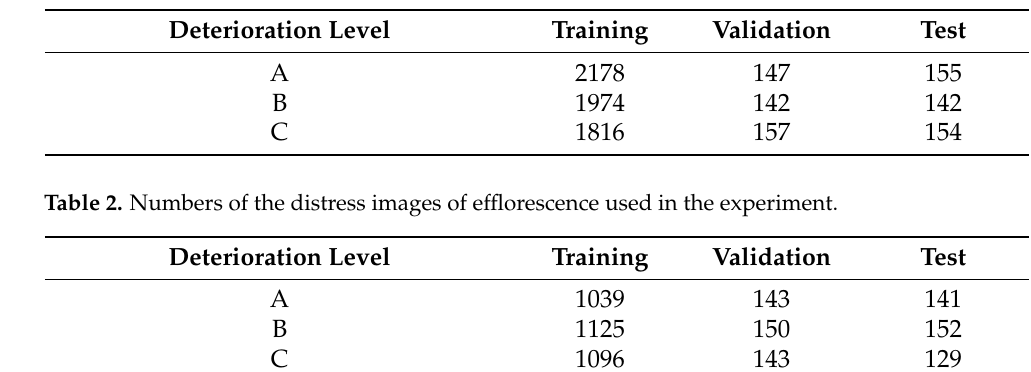
Table 1. Numbers of the distress images of corrosion used in the experiment.